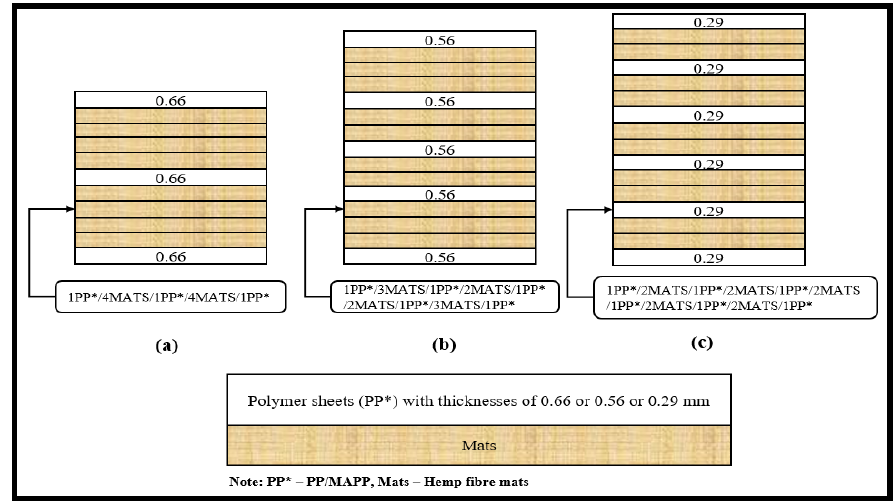
Figure 3. ( a – c ) Schematic diagram representing various stacking arrangements used to produce composites with 40 wt% fibre contents. The arrangements of fibre mats and the polymer sheets depend on the thickness of the sheets used.